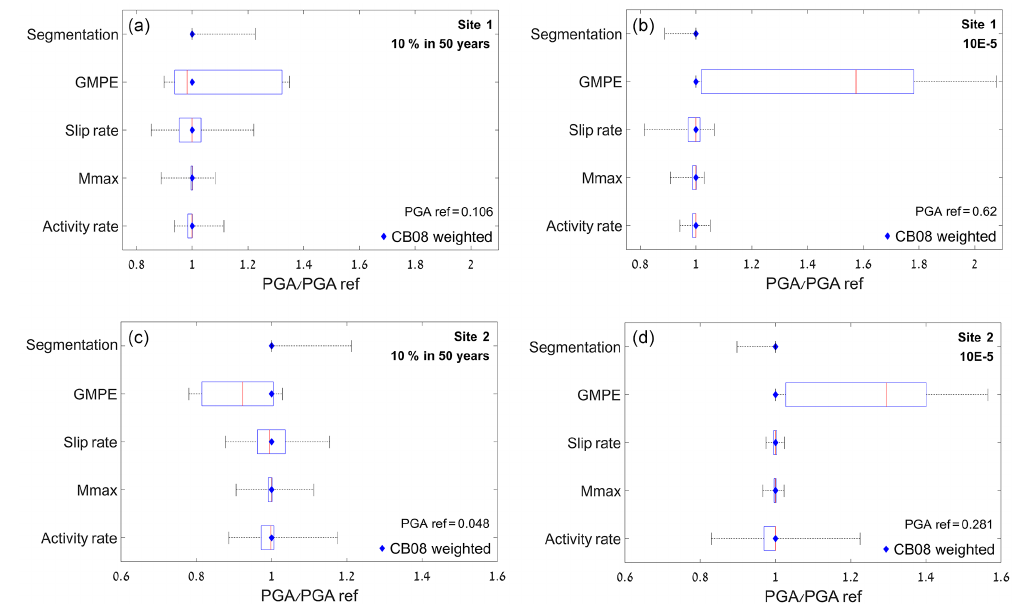
Figure 13. Summary plots, showing the overall relative effect of the uncertainty associated with four different parameters on hazard results using model 5. Site 1 (a, b) vs. site 2 (c, d) , at two different recurrence intervals: 1 / 475 years (a, c) vs. 1 / 10 5 years (b, d) . The blue diamond is the weighted average of model 5 using the CB08 GMPE. The red line is the median value, and the box represents the 25th and 75th percentiles of the